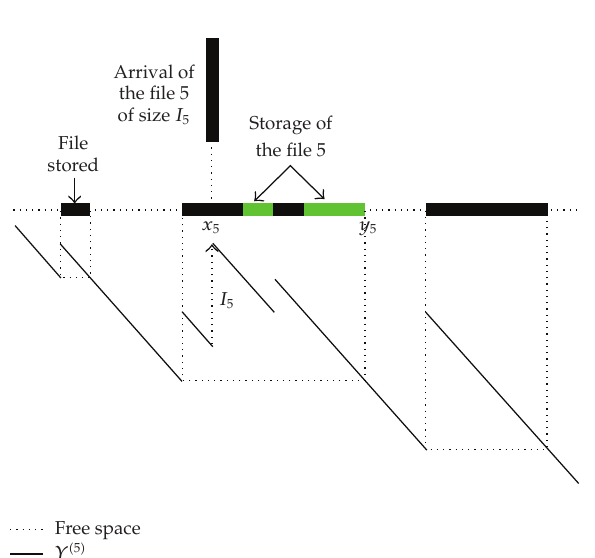
Figure 1: Arrival and storage of the 5-file and representation of Y (cid:2) 5 (cid:3) . The first four files have been stored without splitting and are represented by the black